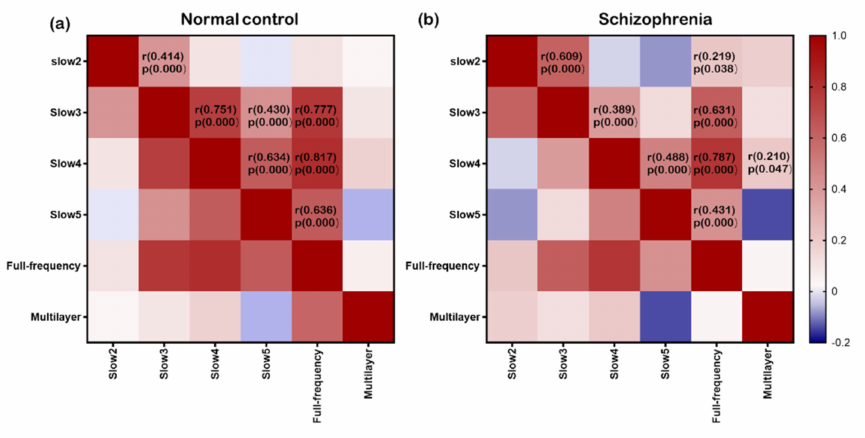
Figure 6. Panels ( a , b ) represent the clustering coefficient correlations between pairs of layers in normal controls and patients with schizophrenia. The self-correlations are equal to